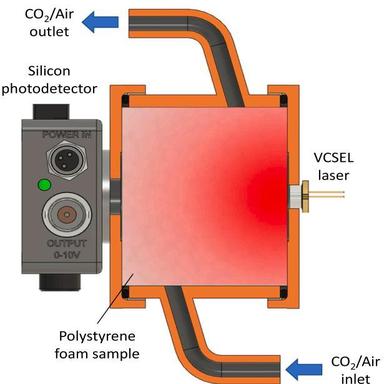
Design of the 3D printed GASMAS flow cell with the VCSEL diode and amplified detector (Si photodiode) and visualization of light scattering phenomenon (in red color). (For interpretation of the references to color in this figure legend, the reader is referred to the web version of this article.)